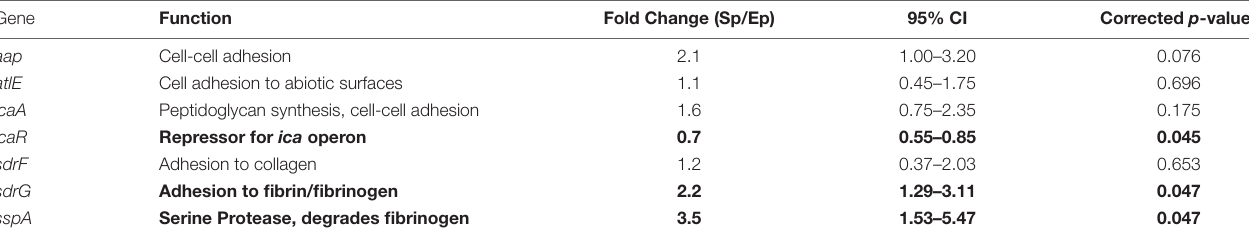
TABLE 1 | Fold change in gene expression for stationary (Sp) versus exponential phase